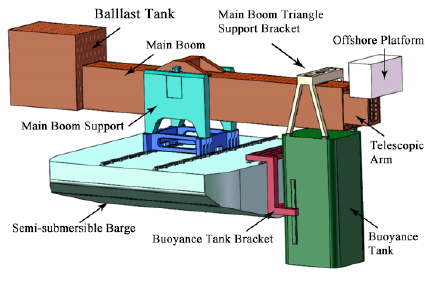
Figure 3. Lifting Arm System Structure.